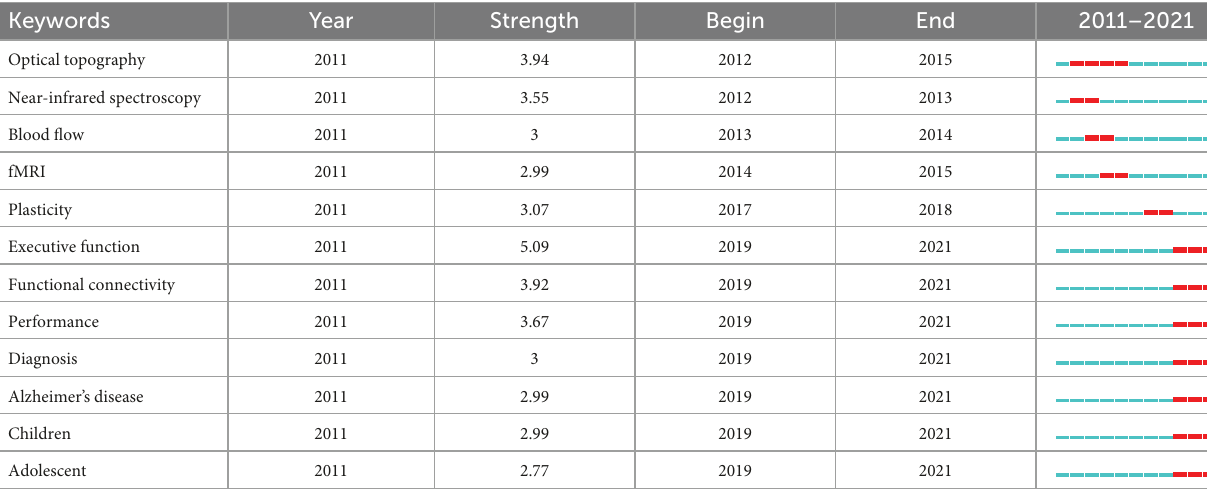
TABLE 4 Top 12 keywords with the strongest citation bursts.